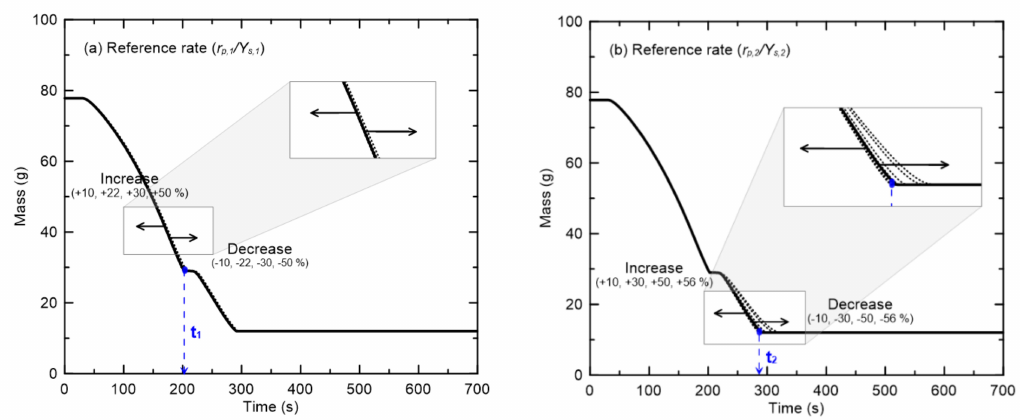
Figure 11. Sensitivity analysis of the reference rates in two pyrolysis reactions (( a ) r p ,1 / Y s ,1 and ( b ) r p ,2 / Y s ,2 ) on mass